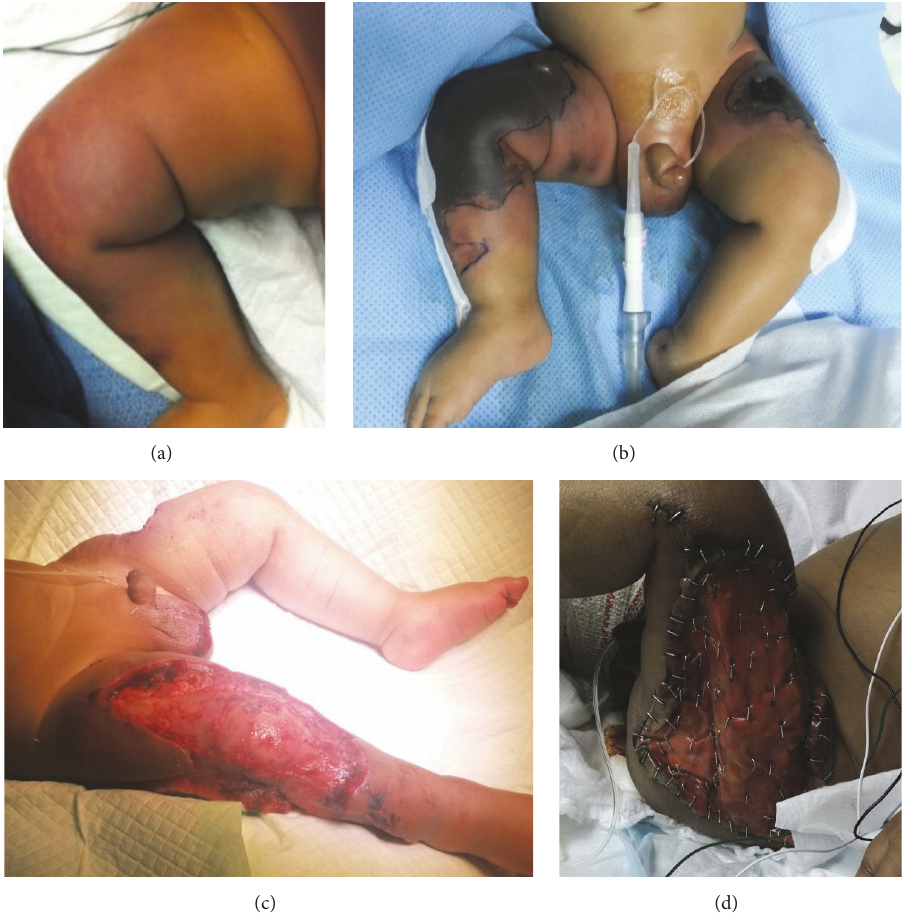
Figure 1: Skin changes at various stages: (a) on the 6th day of hospitalization showing discoloration after the muscle biopsy; (b) on the 8th day of hospitalization showing hemorrhagic necrosis; (c) on the 12th day of hospitalization after fasciotomy and debridement; (d) on the 12th day showing Integra